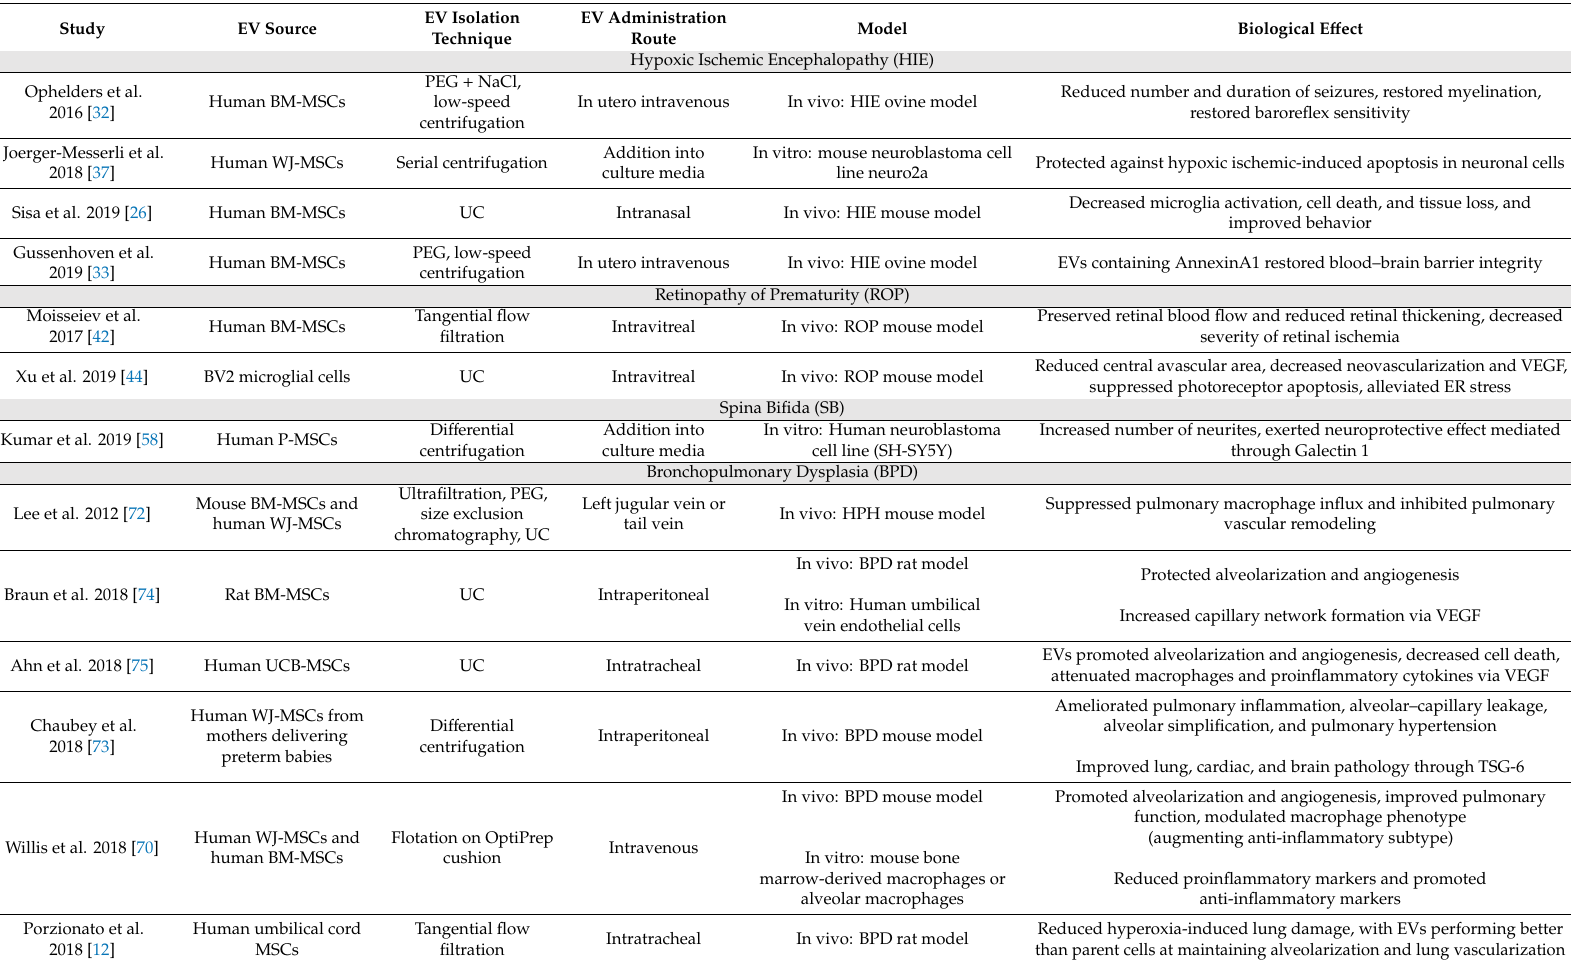
Table 1. Studies reporting the use of EVs as treatment for neonatal